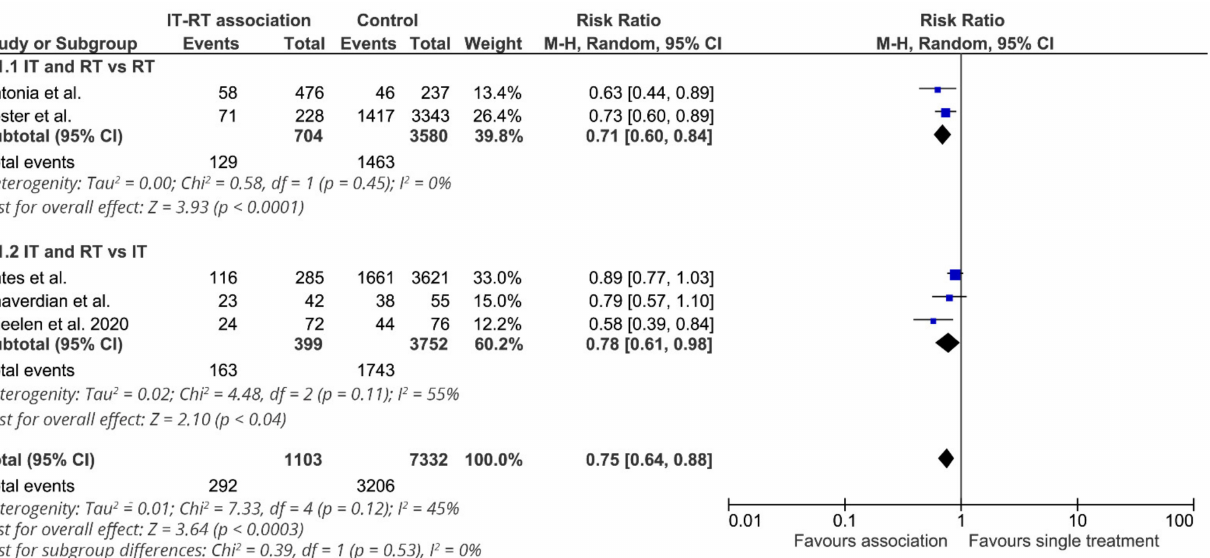
Figure 2. 1-year overall survival. Meta-analysis of 5 studies of ICI-RT association: 2 studies of ICI-RT vs. RT alone ( a ) and 3 studies of ICI-RT vs. IT alone ( b ). The risk ratio (RR) and 95% confidence interval (CI) for the effect of treatment on 1-year overall survival are shown on a logarithmic scale. Studies are arranged by publication year. Theelen study is a pooled analysis of two